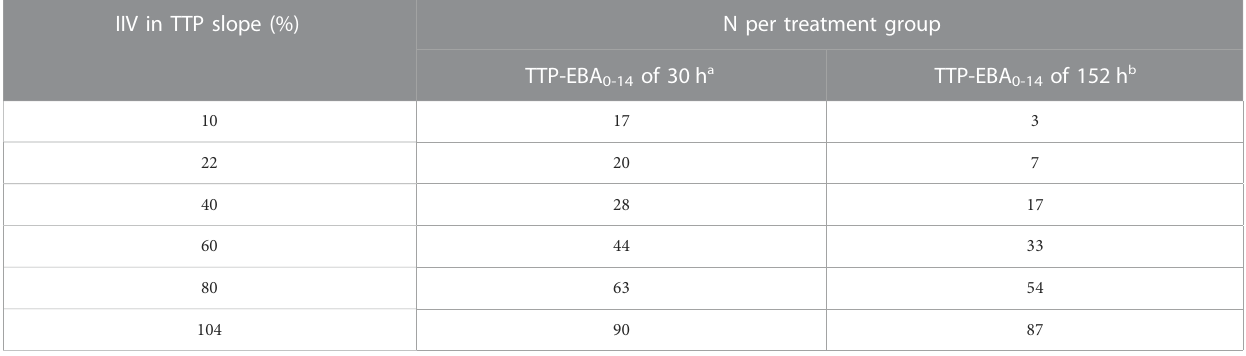
TABLE 3 Sample size per group in an early bactericidal activity (EBA) clinical trial needed to detect an effect difference between two treatment groups with 80% powerata5%signi fi cancelevelunderdifferentinter-individualvariability(IIV)intime-to-positivity(TTP)slope.Powercalculationswereperformedusingamono- exponential model with an effect difference between two treatment groups of 50%, various changes in TTP between days 0 and 14 (TTP-EBA 0-14 ), and inter- individual variability (IIV) in TTP slope. For each scenario, power calculations included a minimum of 3